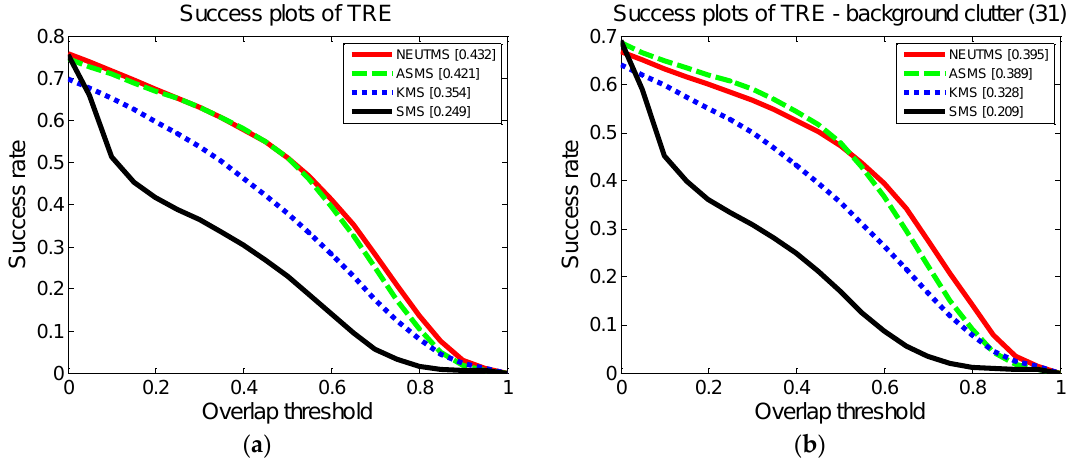
Figure 7. Success plots of temporal robustness evaluation (TRE): ( a ) Success plots of TRE over all the testing sequences; ( b ) Success plots of TRE over all the 31 testing sequences included the challenge of BC. The value shown between the brackets is the AUC value corresponds to the tracker.